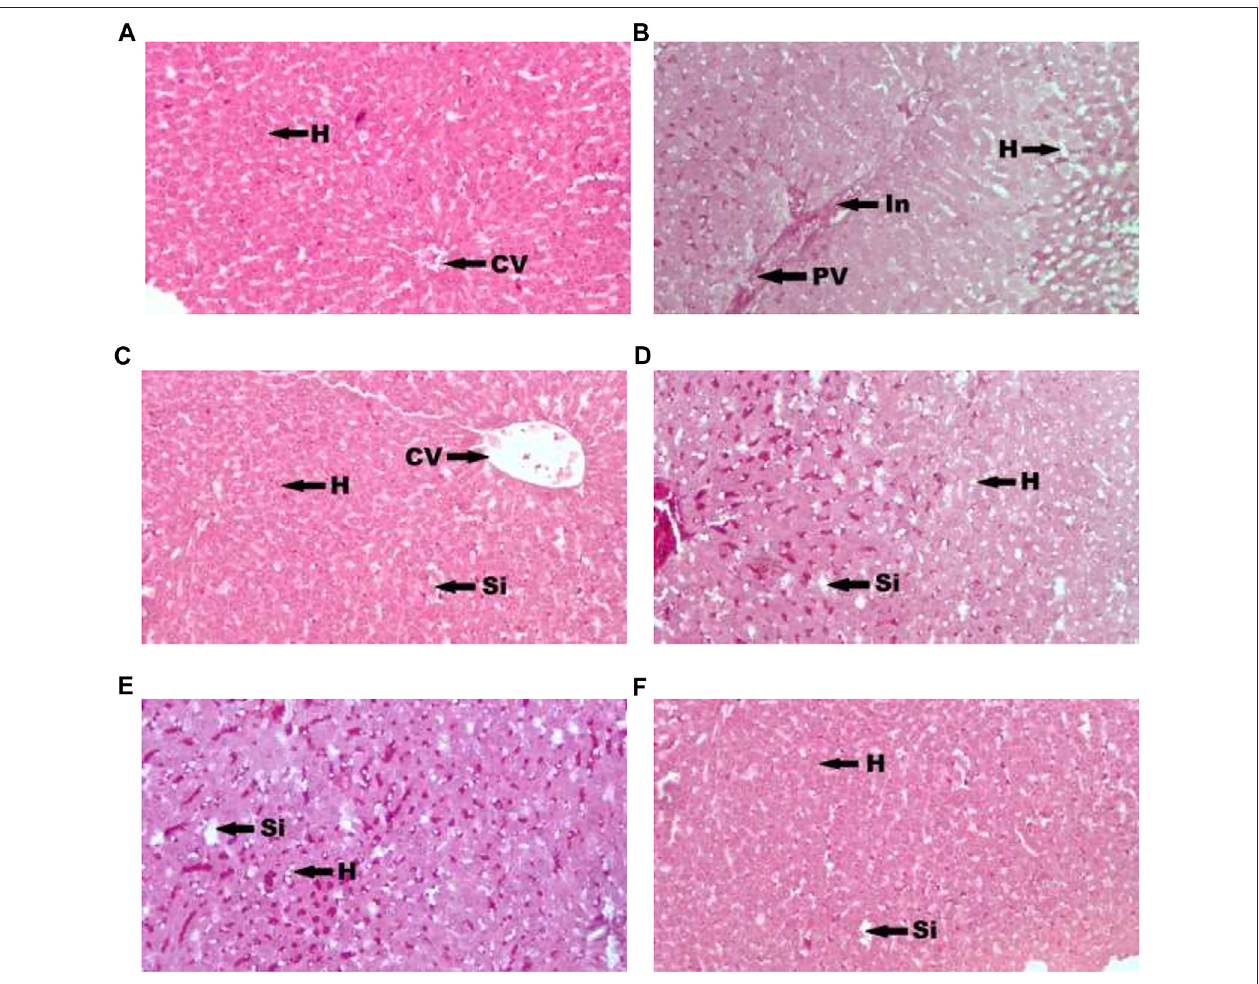
FIGURE 2 | Photomicrograph of a section of liver of normal control (A) , diabetic control (B) , glibenclamide 20 mg/kg (C) , Spondias mombin 125 mg/kg (D) , Spondiasmombin250 mg/kg (E) ,Spondiasmombin500 mg/kg (F) .H-hepatocytes,CV-centrilobularvein,PV-Portalvein,In-PeriportalIn fl ammation,andSi-sinusoids. H&E